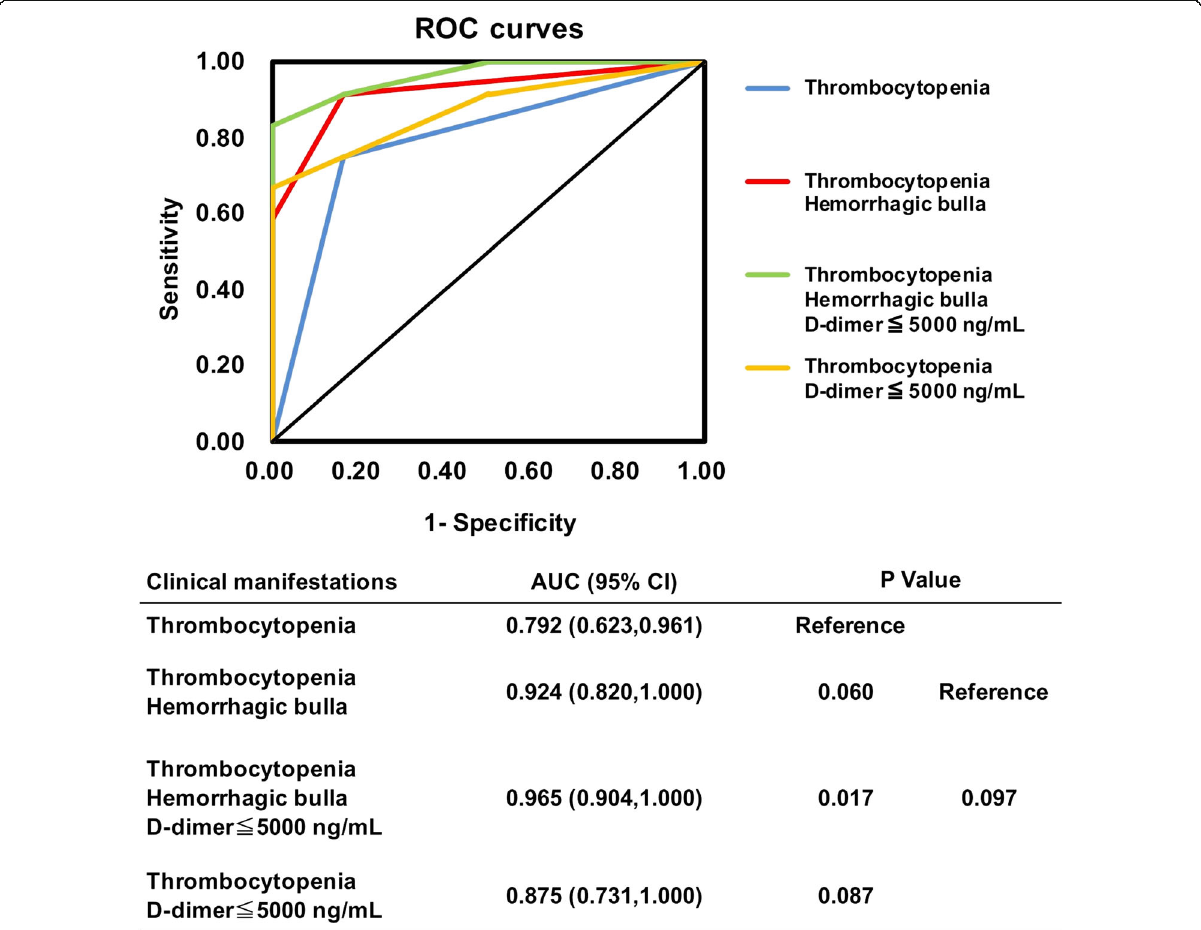
Fig. 1 Receiver-operating characteristic (ROC) curves for the different combinations of clinical manifestations in distinguishing D. acutus envenomation from D. siamensis envenomation. Thrombocytopenia means platelet count <100×10 3